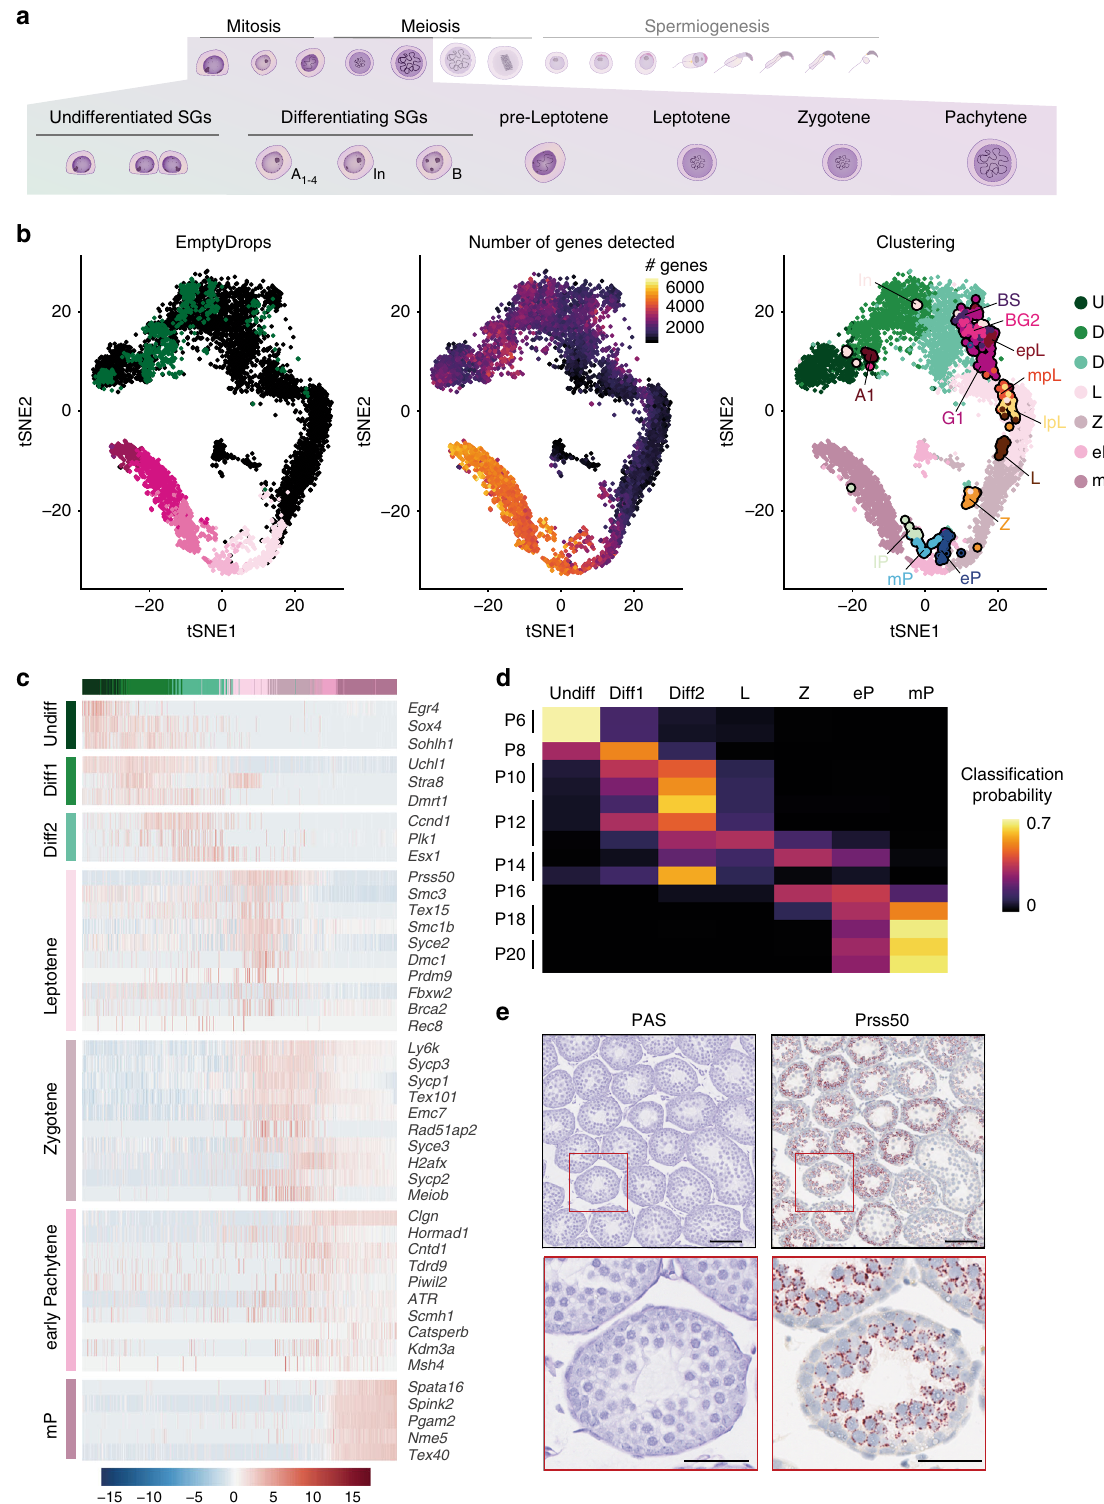
Pou5f2 , which we identi fi ed as a marker gene for diplotene Pou5f2 in adult testes con fi rmed the speci fi c expression